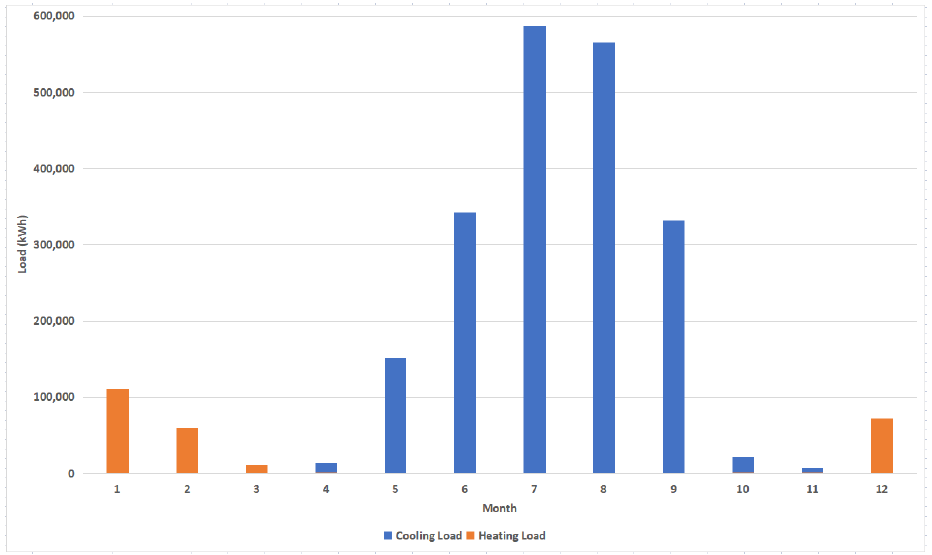
Figure 5. Monthly heating and cooling load of sample building.